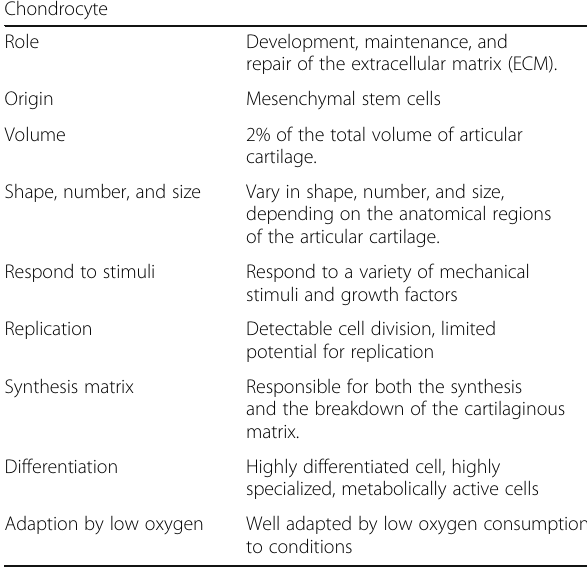
Table 4 Properties of articular cartilage